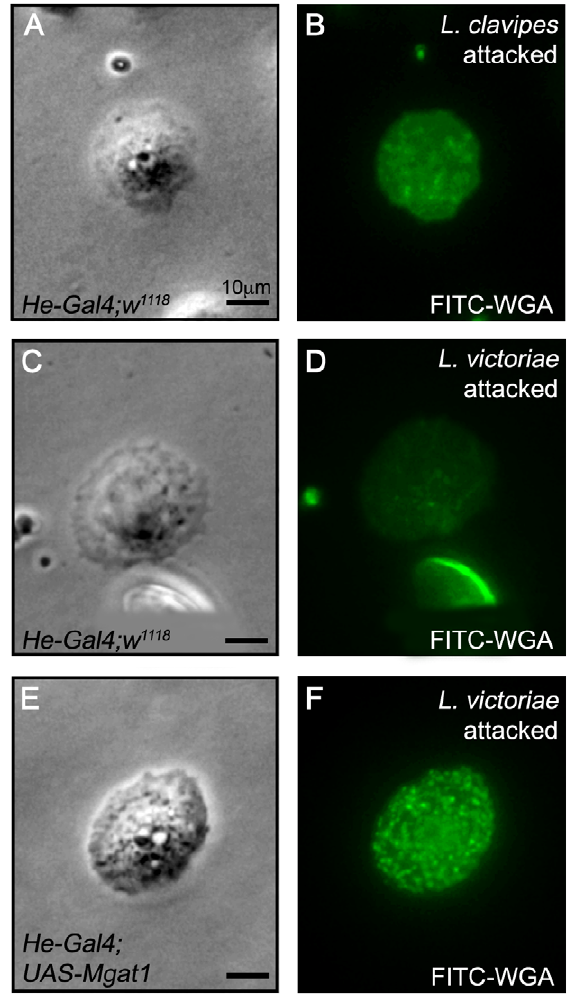
Figure 8. Lamellocyte WGA staining was reduced in L.victoriae attacked larvae and restored by Mgat1 overexpression. Paired brightfield and FITC images of hemocytes stained with FITC-WGA 24– 48 hours following attack by the indicated wasp. (A–D) Lamellocytes from He-Gal4;w 1118 larvae were WGA + following L. clavipes attack (A,B), but were WGA 2 following L. victoriae attack (C,D). (E,F) The WGA + staining was restored to L. victoriae attacked larvae by hemocyte specific expression of Mgat1 in He-Gal4;UAS-Mgat1 larvae. Scale bars indicate 10 m m.